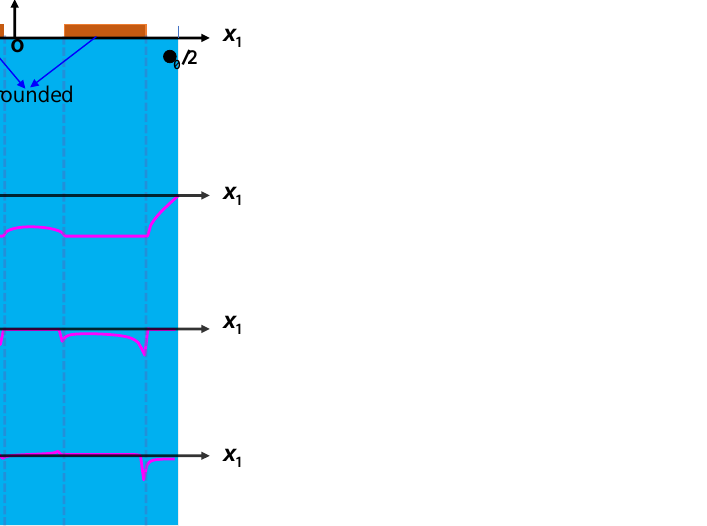
Figure 3. Surface potential, surface charge density and tangential component of the electric field distribution under a periodic EWC SPUDT.